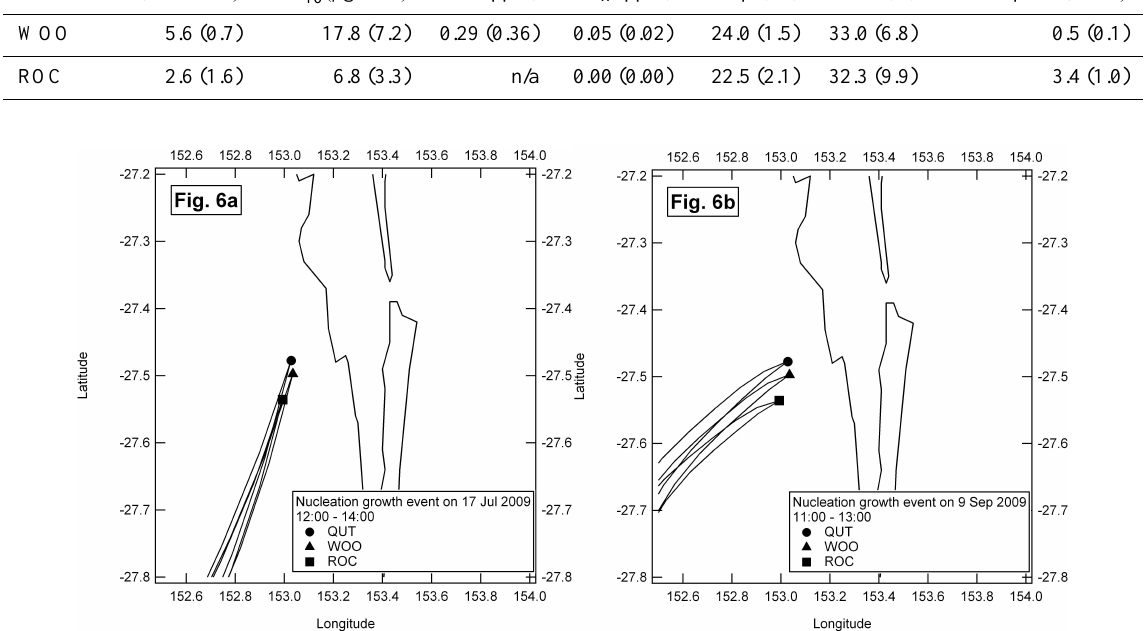
Fig. 6. Back-trajectories for the first two hours of each event: (a) 17 Jul 2009 and (b) 9 Sep